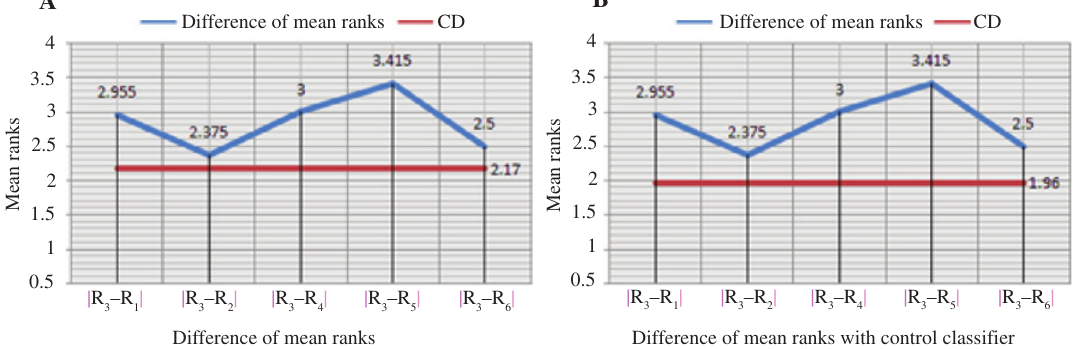
Figure 8: Graphical Representation of Comparison of Multiple Classifiers for (A) Nemenyi’s Test and (B) Bonferroni-Dunn’s Test Before Applying